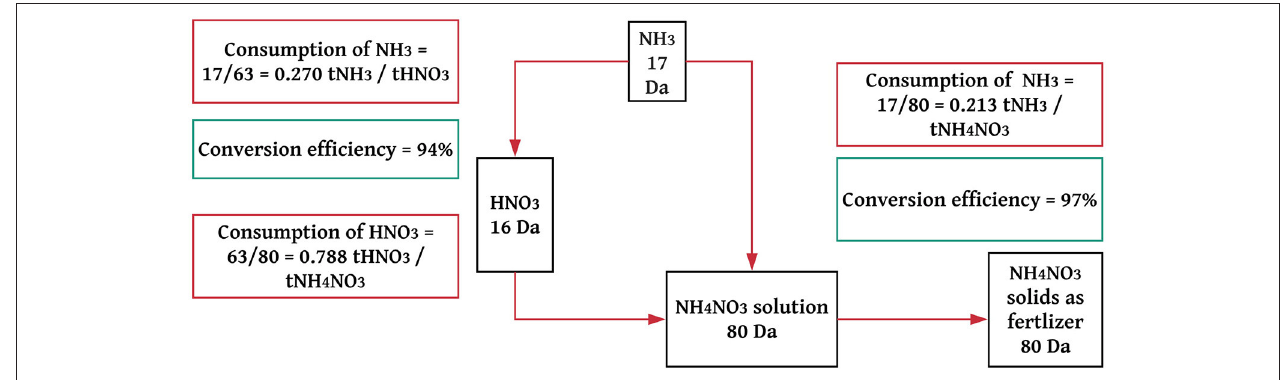
FIGURE 8 | Schematic diagram of conversion of ammonia into ammonium nitrate in a fertilizer plant. Data Source: Yara International ASA (Jan-Petter,